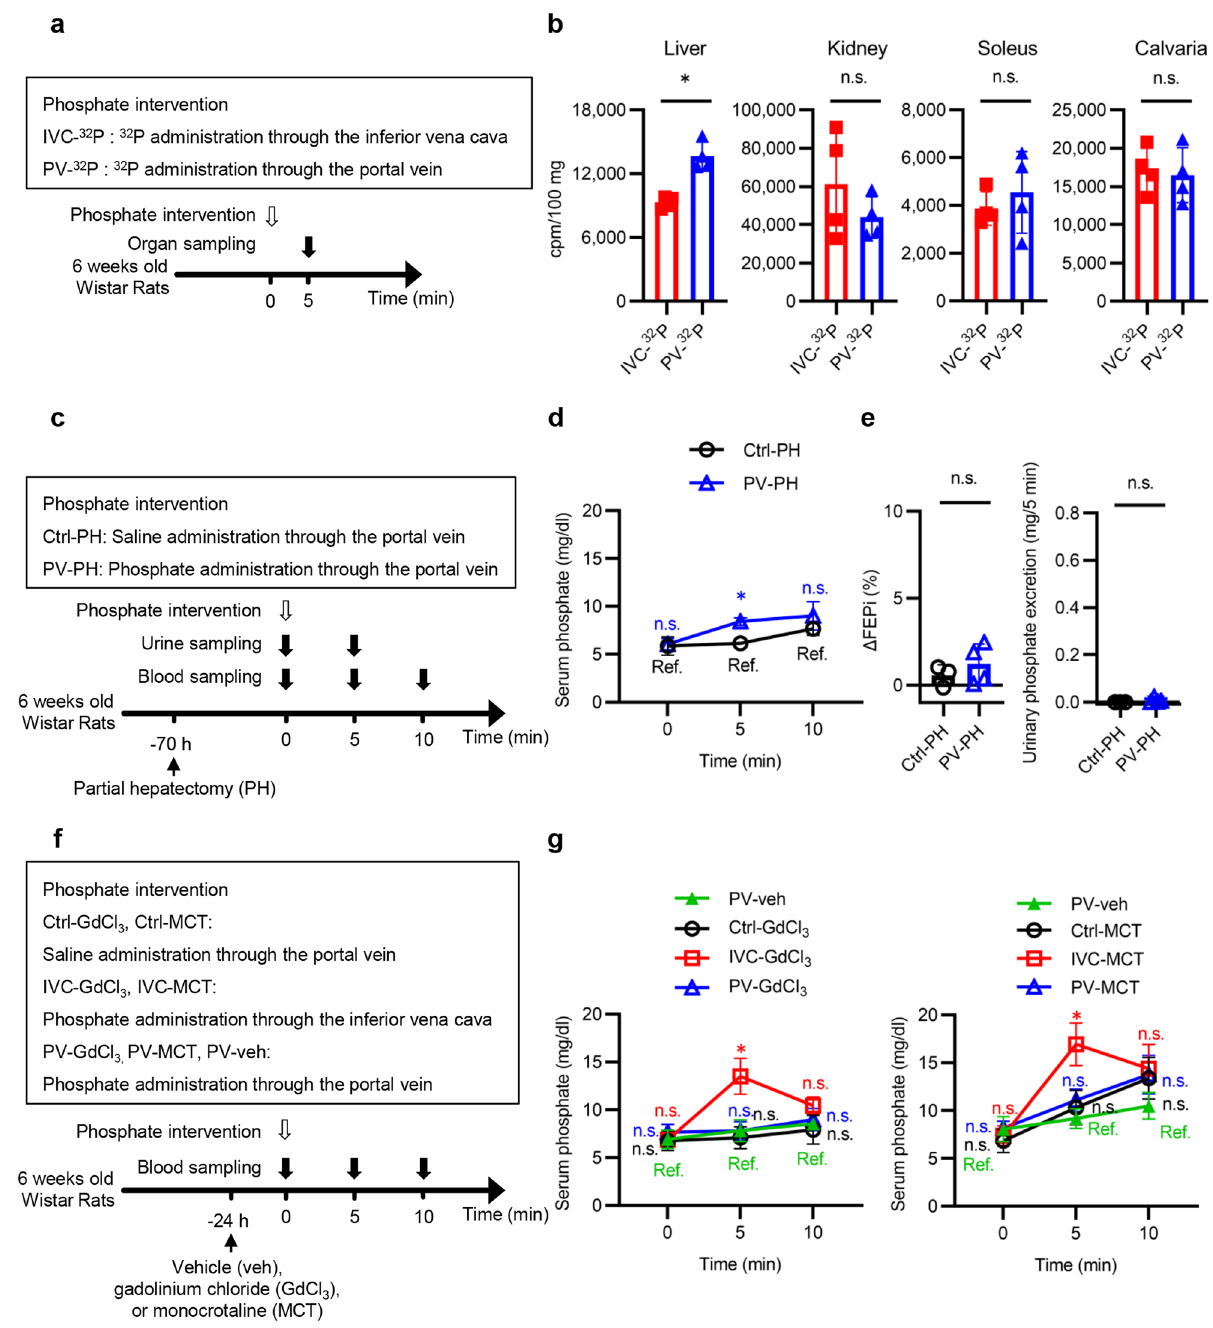
Figure 3. Hepatic phosphate uptake is essential in maintaining serum phosphate levels in the PV group at 5 min. ( a ) Experimental design of ( b ). The normal rats were randomly divided into two groups, IVC- 32 P and PV- 32 P. The rats were administered a radiolabeled Na 2 HPO 4 /NaH 2 PO 4 solution (20 mM phosphate, 154 mM sodium, pH 7.4, 3700 Bq/ml 32 P, 1.0 ml/animal) through either the inferior vena cava or portal vein at 0 min. ( b ) 32 P levels in the liver, kidney, soleus, and calvaria at 5 min (n = 4 rats per group). ( c ) Experimental design of ( d ) and ( e ). Partially hepatectomized (PH) rats were randomly divided into Ctrl-PH and PV-PH groups. Seventy hours after the PH operation, rats in the Ctrl-PH and PV-PH groups received phosphate interventions as in the Ctrl and PV groups. ( d ) Serum phosphate concentration at the indicated times (n = 4 rats per group). Serum samples were collected from the inferior vena cava. ( e ) ΔFEPi between 0 and 5 min and urinary phosphate excretion during the 5-min period (n = 4 rats per group). ( f ) Experimental design of ( g ). Gadolinium chloride (GdCl 3 ) or monocrotaline (MCT) pretreated rats were further divided into each of the three groups according to the phosphate interventions. Rats in the PV-veh group were pretreated with normal saline. Twenty-four hours after